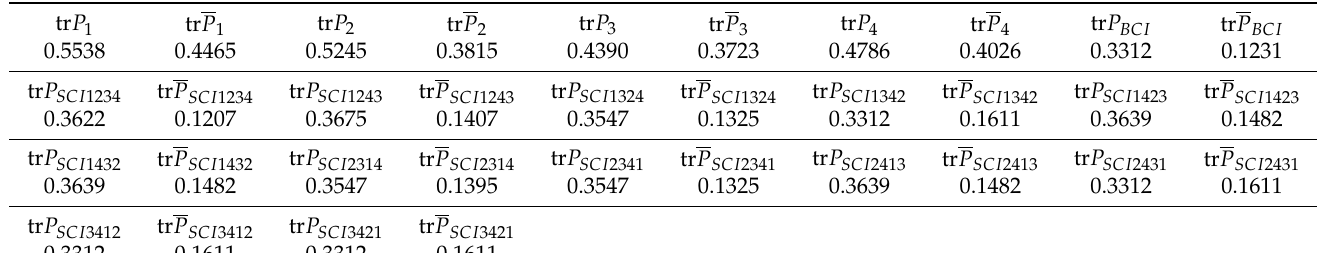
Table 5. The sensitivity of the actual and robust accuracies for the SCI fuser with respect to the orders of